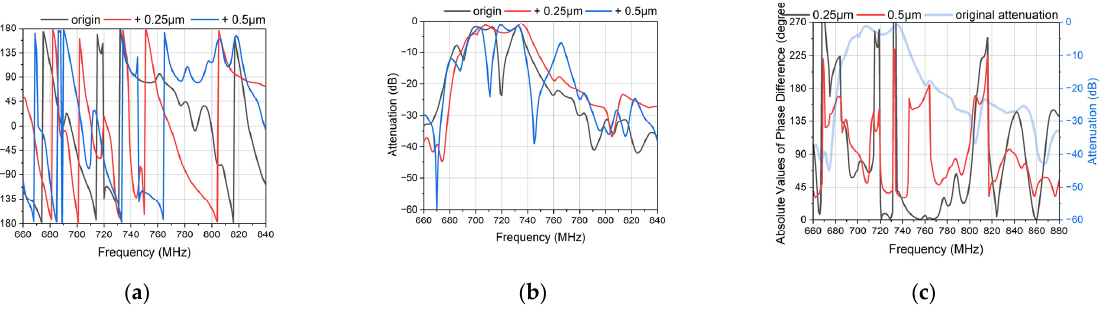
Figure 7. The responses of the phase shifter with different widths of the EWC electrodes. ( a ) The phase of the different widths. The width of red one is 0.25 μ m larger than the width of the black one, and the width of blue one is 0.5 μ m larger than the width of the black one. ( b ) The attenuation of different widths. The width of the red one is 0.25 μ m larger than the width of black one, and the width of the blue one is 0.5 μ m larger than the width of black one. ( c ) The absolute values of the phase difference of the different widths. The width difference of 0.25 μ m is the black one and red one in ( a ). The width difference of 0.5 μ m is the black one and blue one in ( a ).